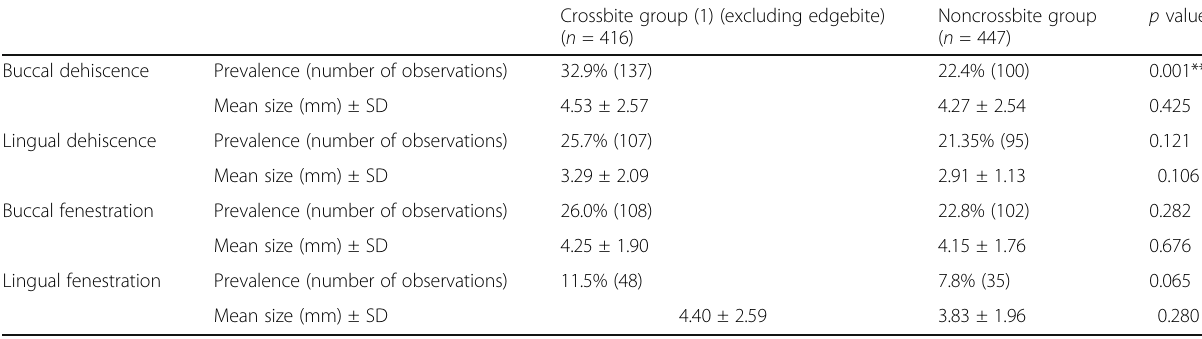
Table 11 Dehiscence and fenestration prevalence and mean size by buccal and lingual surfaces in the crossbite group without teeth in edgebite and the noncrossbite